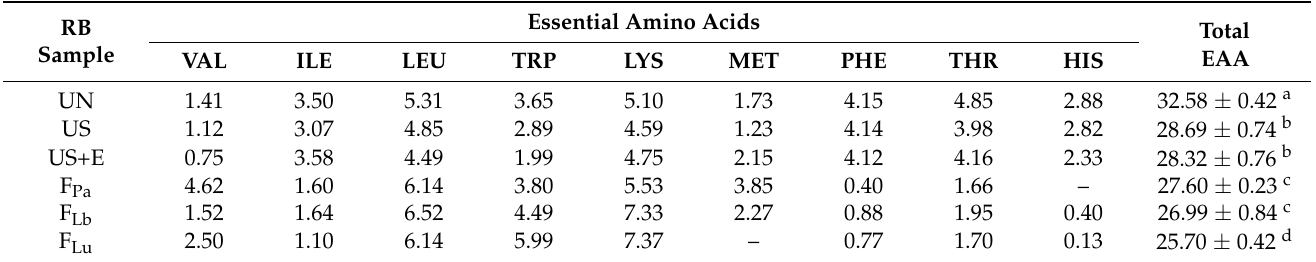
Table 2. Essential amino acids (EAA) (g/100 g protein) in rice bran (RB) after different pre-treatments. RB